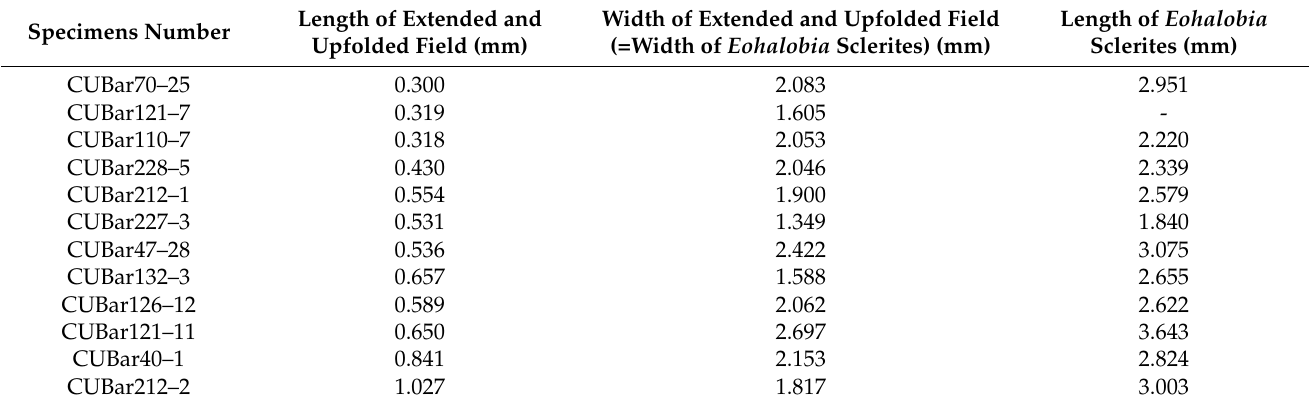
Table 1. Measurements of 12 well-preserved specimens of Eohalobia